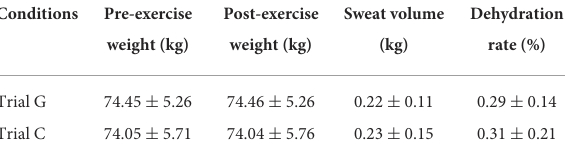
TABLE 1 Changes in sweat volume and dehydration rate of the participants ( ¯ x ± s, n =